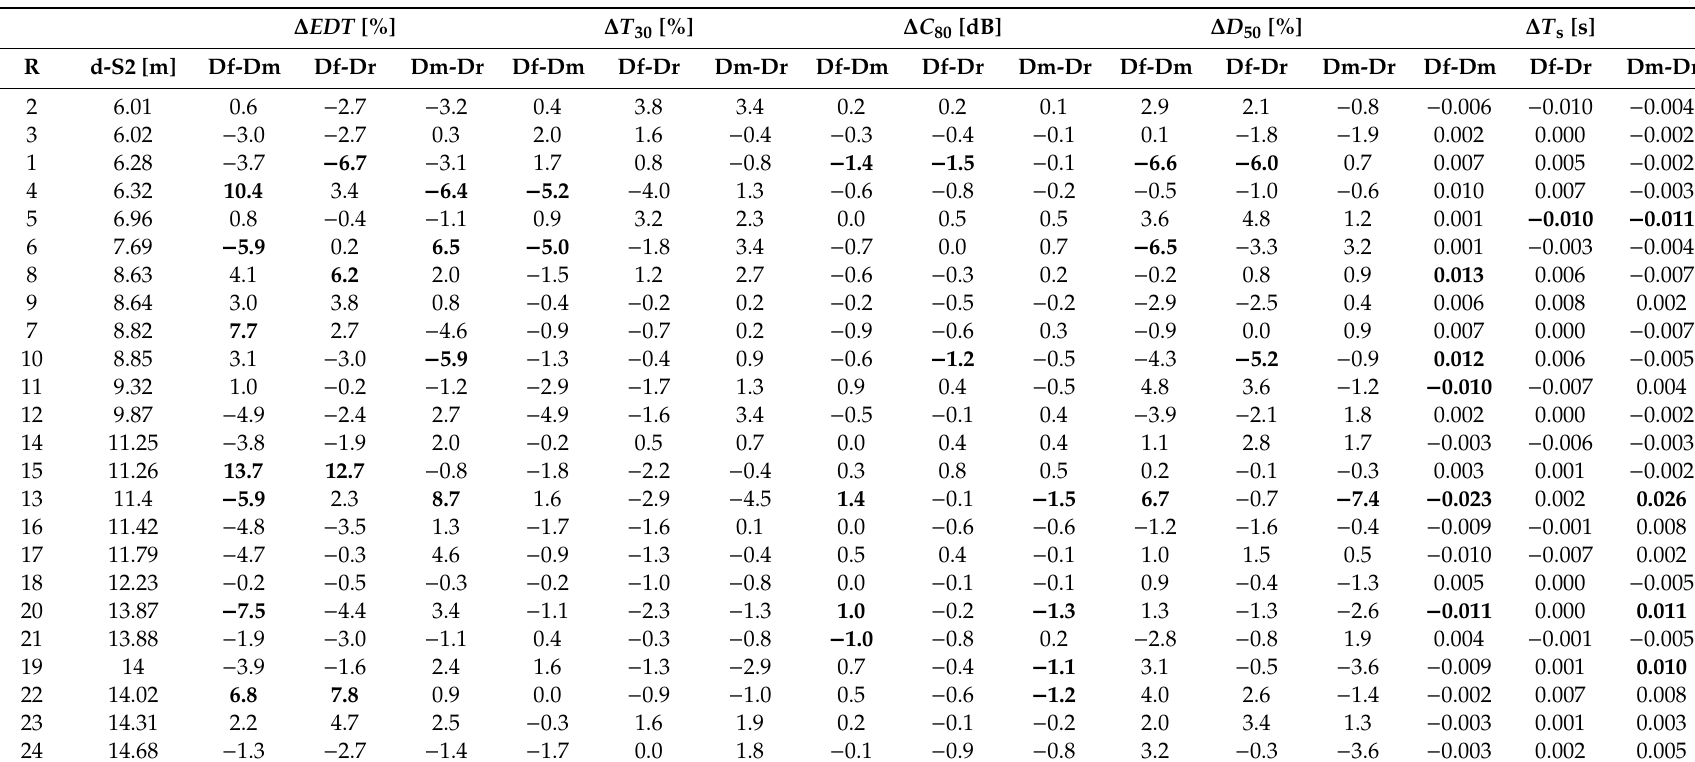
Table A2. Objective acoustic parameter di ff erences between the configurations with di ff erent di ff user locations in the reflective (-R) condition for